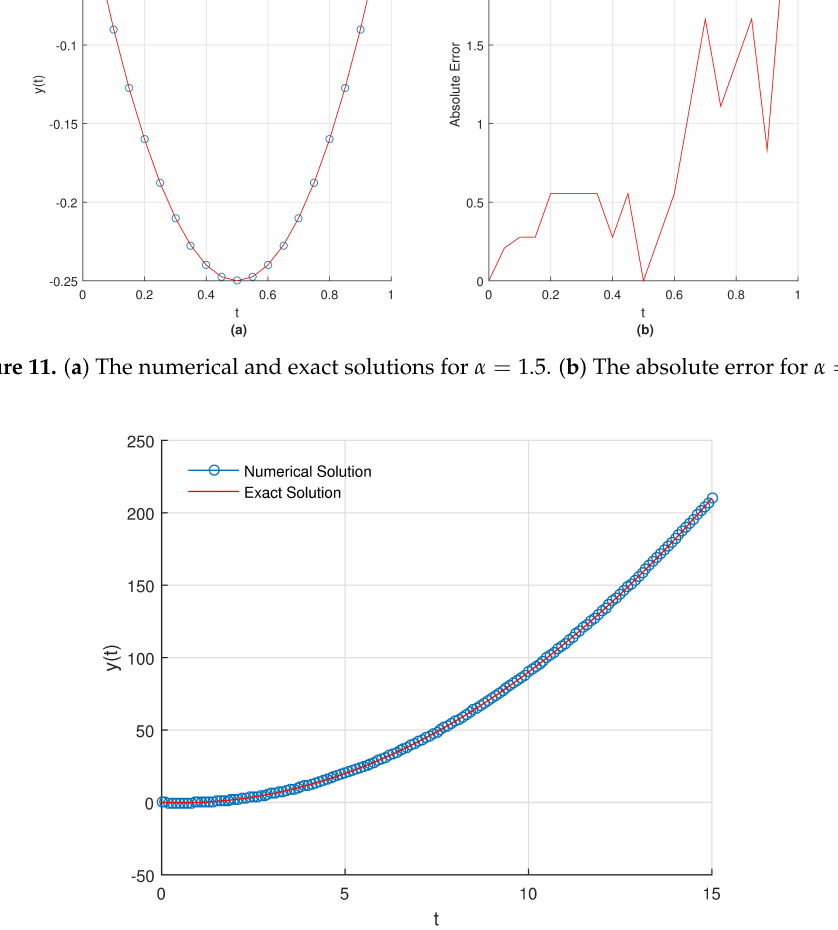
Figure 12. The behaviour of the obtained numerical and exact solutions with α = 1.5 for the interval t ∈ [ 0,15 ] .